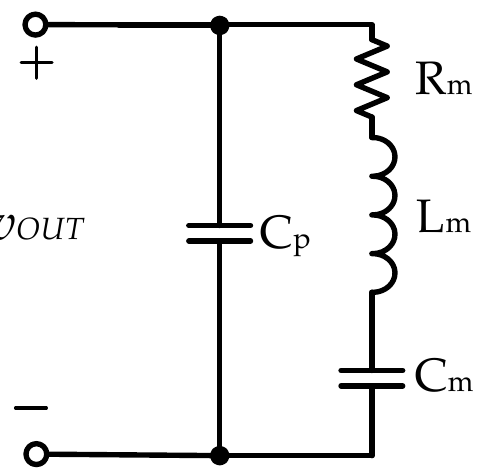
Figure 2. The equivalent circuit model for a piezoelectric ceramic actuator.